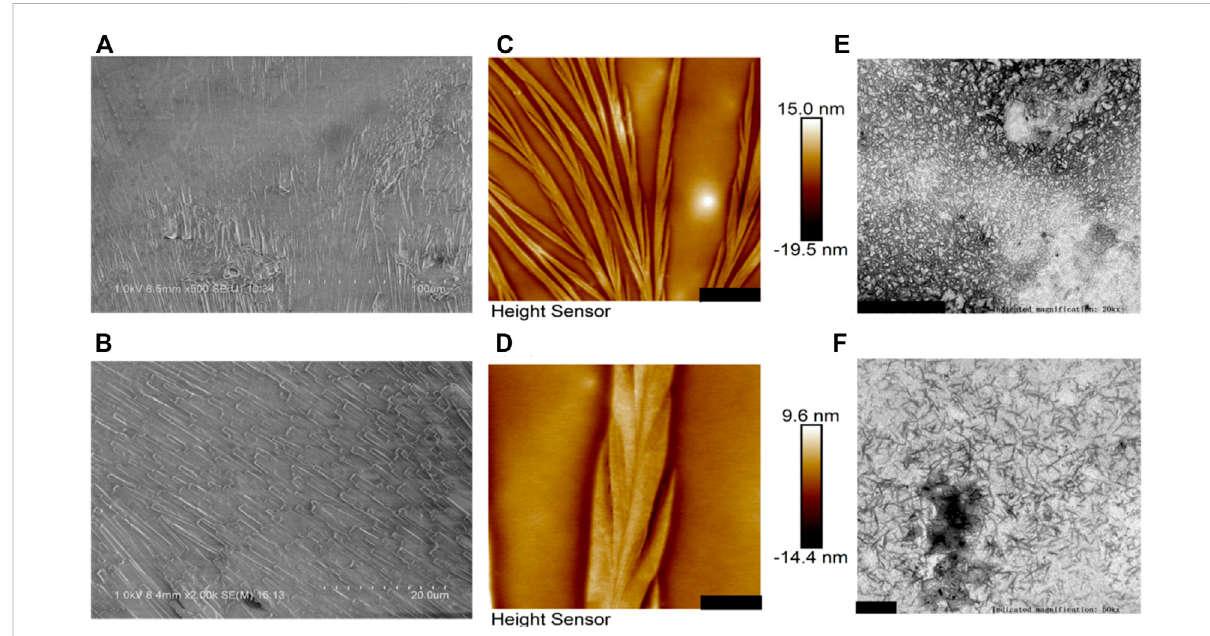
FIGURE 2 MicroscopiccharacterizationsofBalCP20-P3. (A,B) representscalebars=100and20 μ mforSEMofBalCP20-P3,respectively; (C,D) represent scale bars = 3 and 1 μ m for AFM of BalCP20-P3, respectively; (E,F) respresent scale bars = 1 and 200 μ m for TEM of BalCP20-P3,